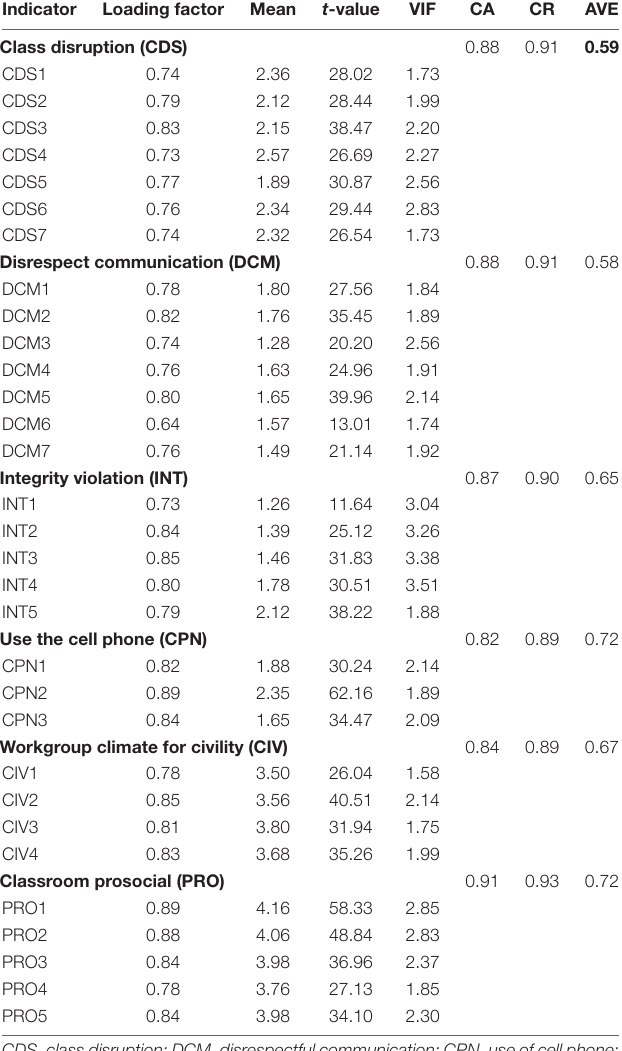
TABLE 2 | The indicator loadings and construct reliability.